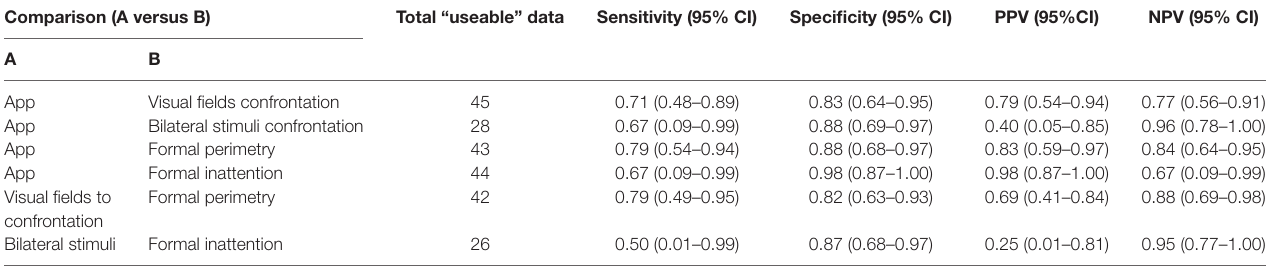
TaBlE 1 | Test accuracy of Stroke Vision app compared to usual screening assessments for visual field deficits and visual inattention. Comparison (a versus